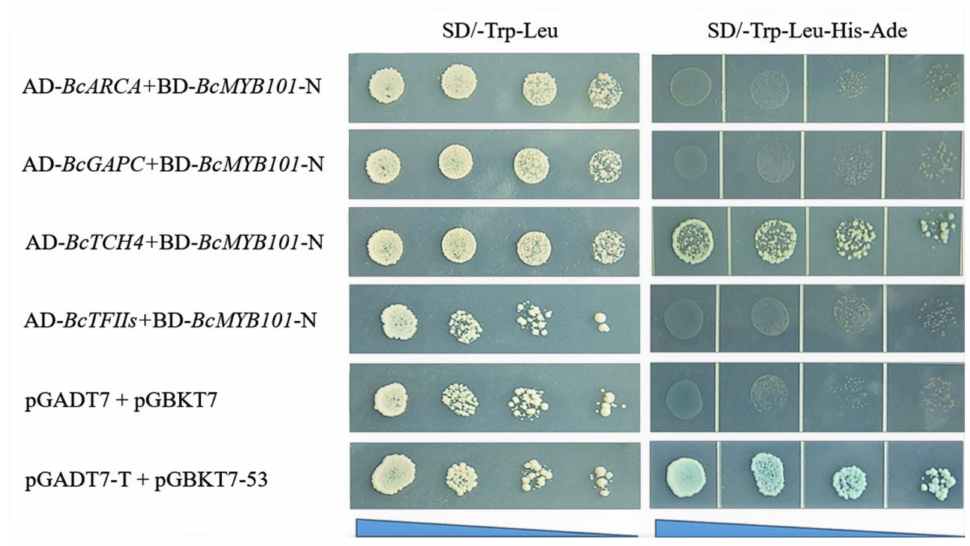
Figure 8. Verification of candidate proteins interacting with BcMYB101. pGADT7 + pGBKT7 and pGADT7-T + pGBKT7-53 were used as the negative and positive control. The blue triangle represents the concentration of yeast solution from high to low (10 0 –10 − 3